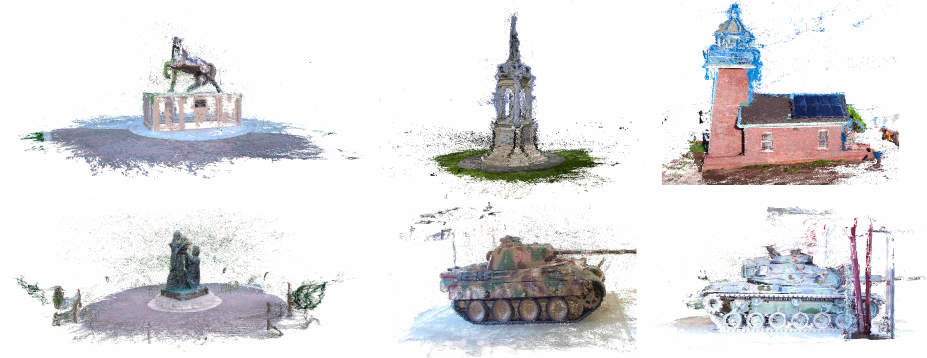
Figure 9. Qualitative results of the intermediate set in the Tanks&Temples dataset.